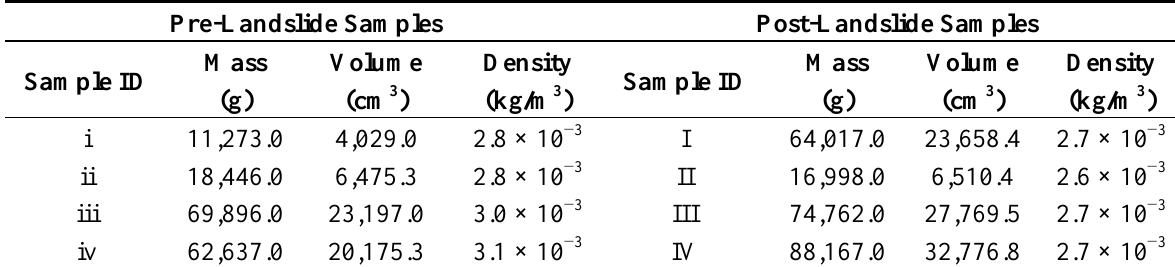
Table 3. Mass, volume, and density of the field